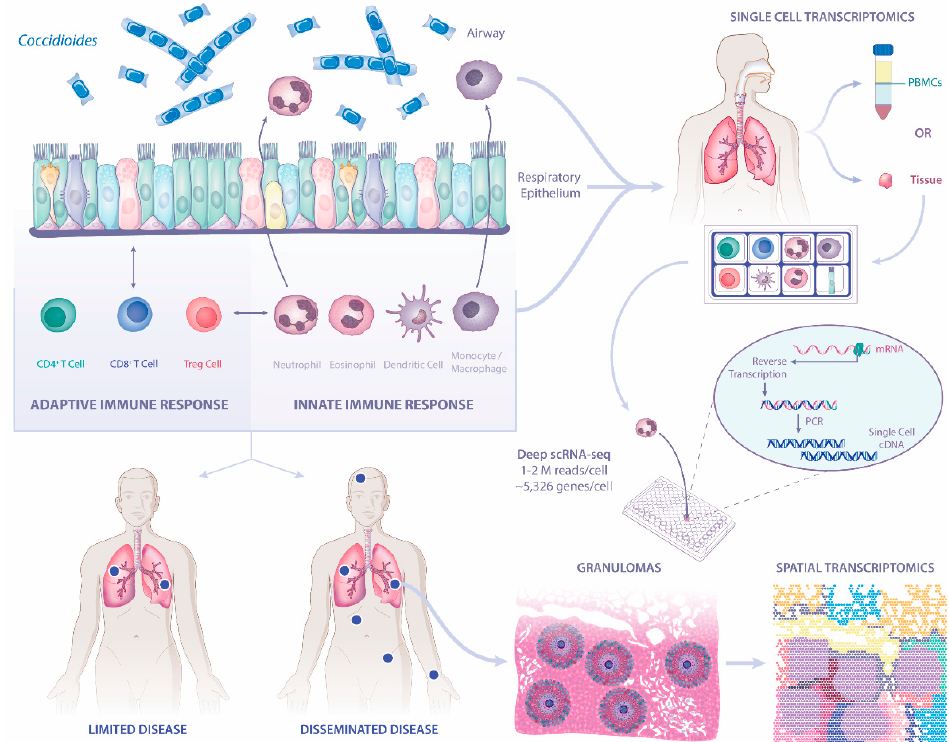
Figure 1. Future pathways of investigation to dissect disease severity in coccidioidomycosis. Immune responses by respiratory epithelial cells, the first point of contact, as well as innate and adaptive immune cells to Coccidioides will enable better understanding of protective immunity. Novel transcriptional technologies, including single-cell RNA sequencing [scRNA-seq] and spatial transcriptomics, can be leveraged using dissociated cells or tissues.